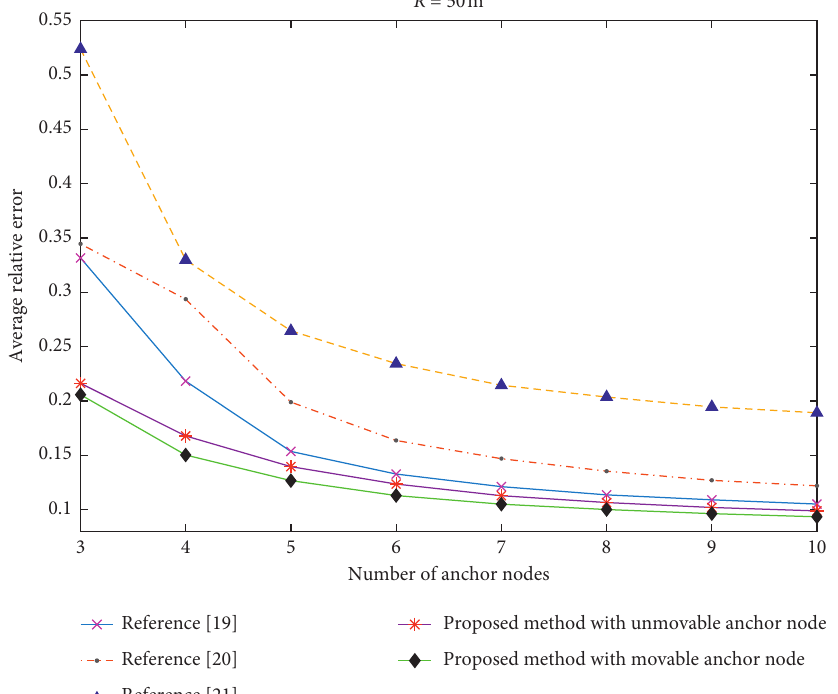
Figure 4: The average relative error with different number of anchor nodes and communication radius 50